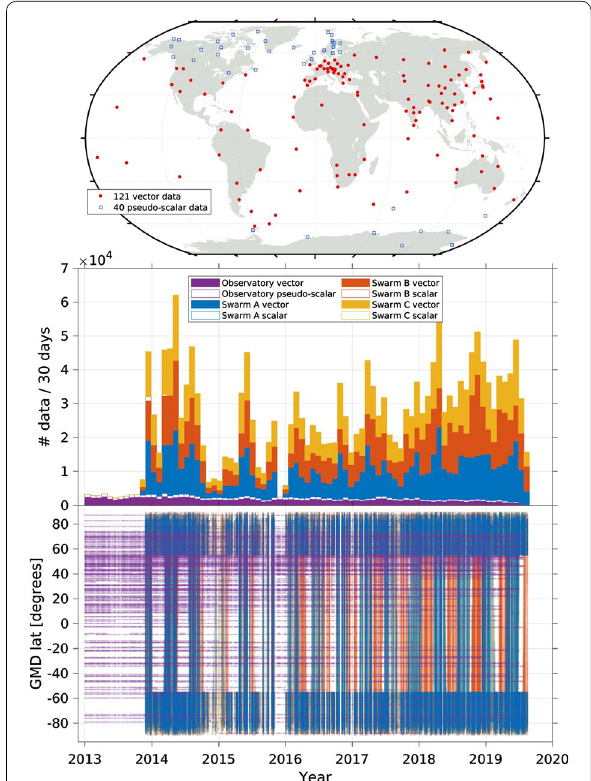
Fig. 1 Distributions of selected satellite and ground data in space and time. Top: Map of ground observatory locations providing hourly mean vector data, those used as projected scalar values for locations above GMD latitude |55 ◦ | are shown as open squares. Middle: Stacked histogram of data coverage in time, in 30 day bins. Solid bars show vector data, hollow bars show scalar data. Bottom: Distribution of all data types by GMD latitude and time; colours of data sources as in middle plot. Note the gaps in the Swarm data are due to the exclusion of orbits with local times between 05:00 and 23:00; Swarm A data mostly plot over Swarm C data due to the proximity of their orbits